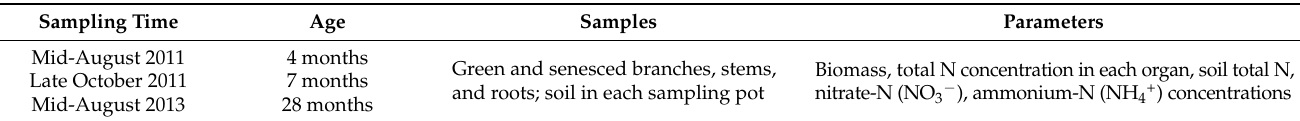
Table 2. The sampling arrangement and parameters of